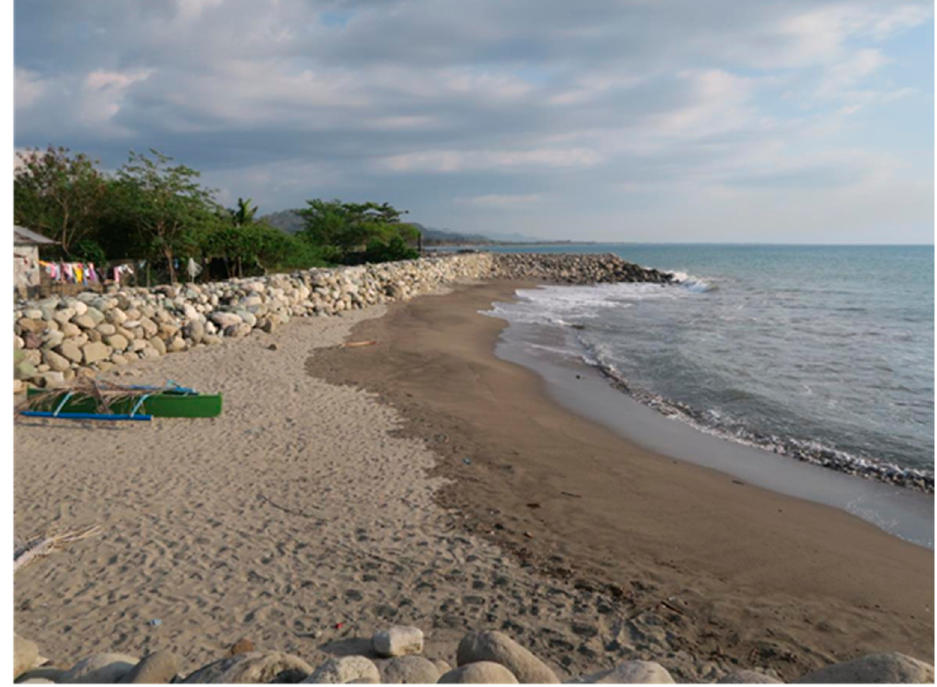
Figure 10. South view from groin No. 4.